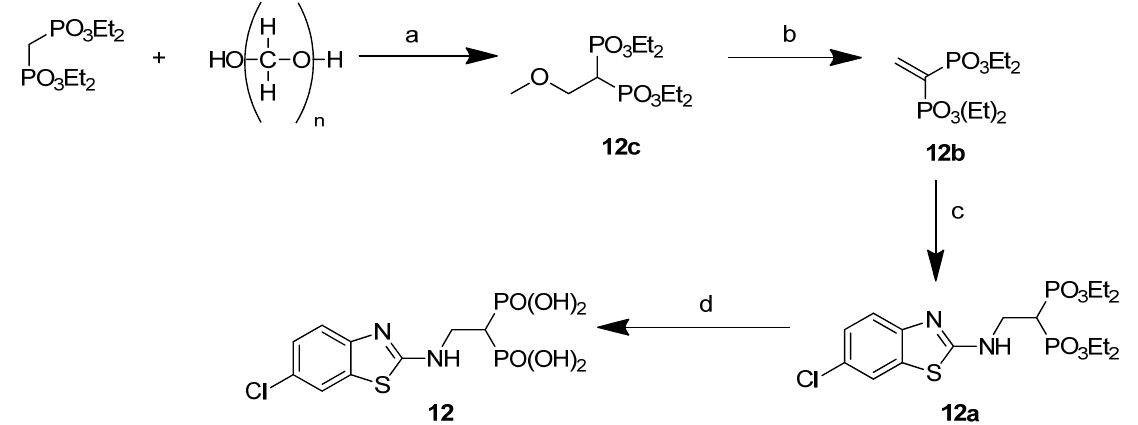
Figure 2. Synthesis of compound 12 . Reagents and conditions: ( a ) diethylamine, MeOH, reflux 24 h, ( b ) p -TsA, toluene, reflux, 6 h (yield a, b 81%); ( c ) 2-amino-6-chlorobenzothiazole, CHCl 3 dry, N 2 , 40 °C, 27 h (65%); ( d ) 3N HCl, reflux, 17 h (96%).